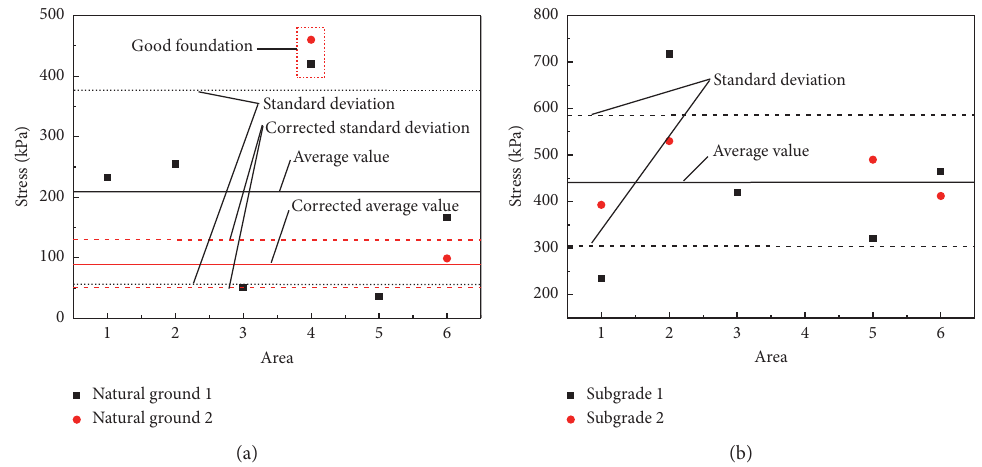
Figure 8: Results of the p - s curves in each test area. (a) Before foundation treatment. (b) After foundation treatment.